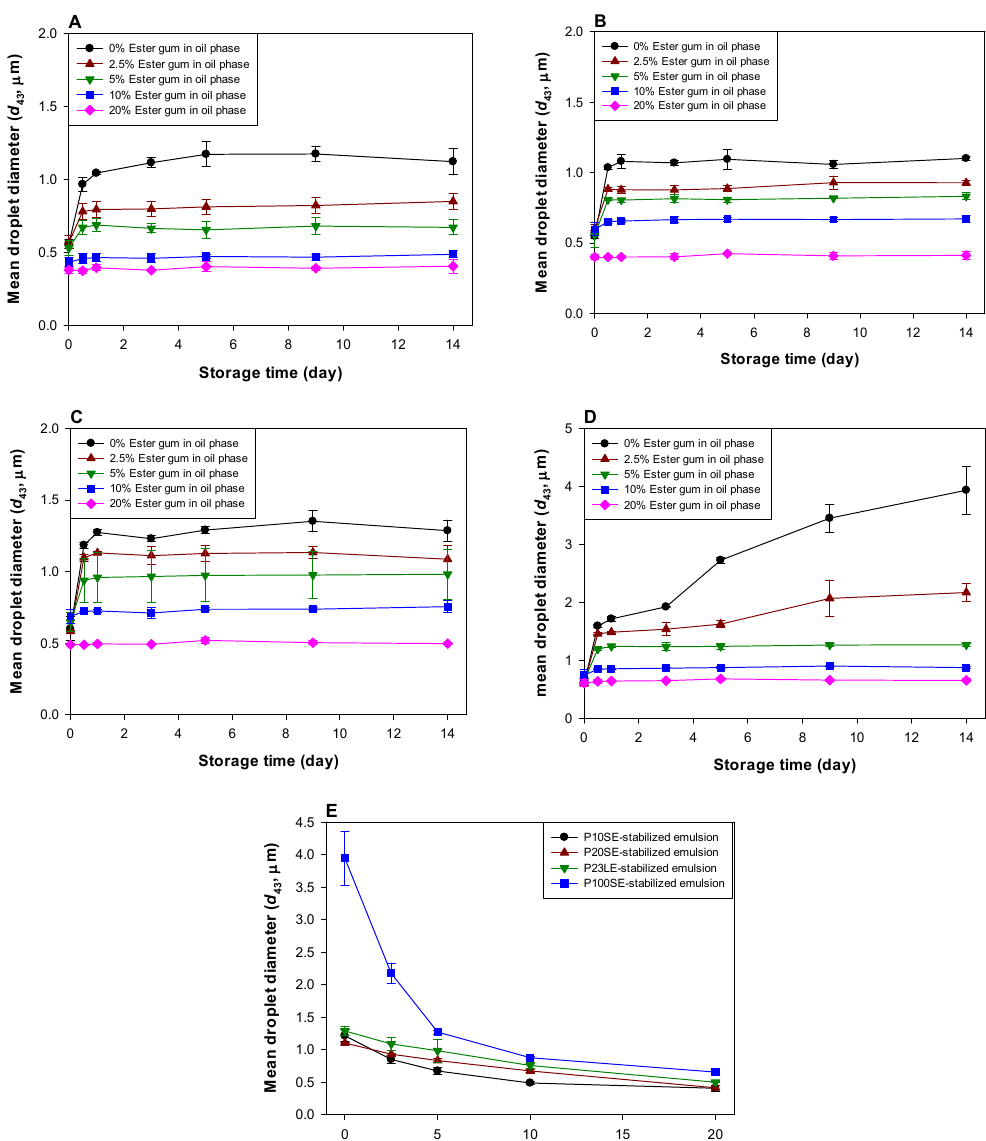
Figure 4. Influence of the addition of ester gum into the oil phase on the mean droplet diameter (volume-length mean diameter, d 43 ) of orange oil emulsions stabilized with ethylene glycol alkyl ether emulsifiers. ( A ): P10SE-stabilized emulsion, ( B ): P20SE-stabilized emulsion, ( C ): P23LE-stabilized emulsion, ( D ): P100SE-stabilized emulsion, ( E ): droplet size in emulsions after 14-day storage. For changes in the mean droplet diameter (area-volume mean diameter, d 32 ) of orange oil emulsions, see Supplementary Figure S1.